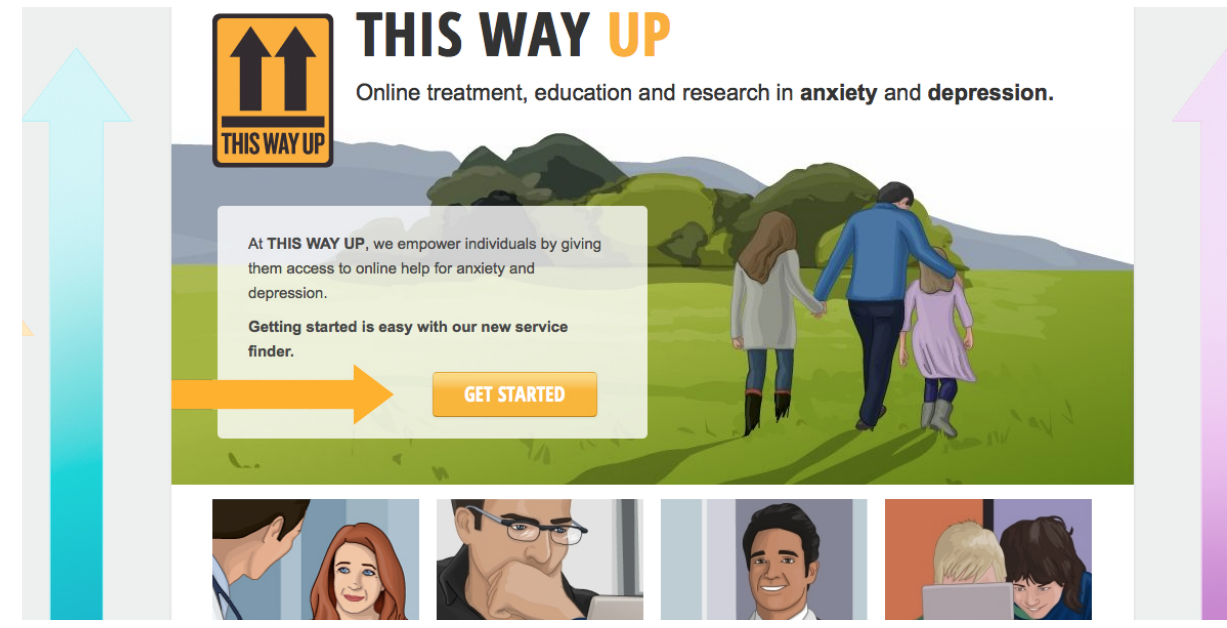
Figure 13. This Way Up welcome